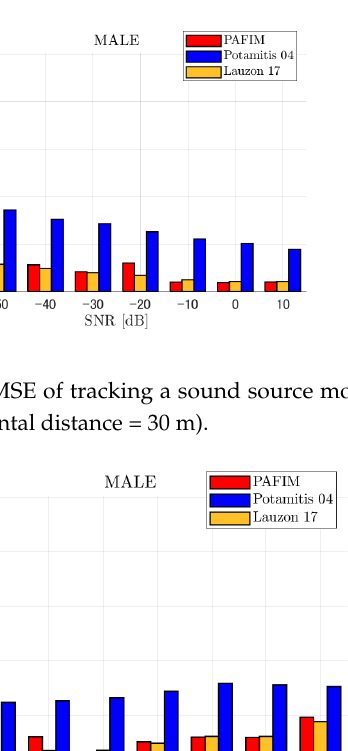
Figure 12. RMSE of tracking a sound source moving in a circle emitting white noise.